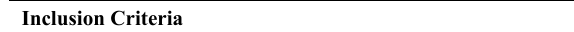
Table 1. Main selection criteria (inclusion and exclusion) used in the filtering process